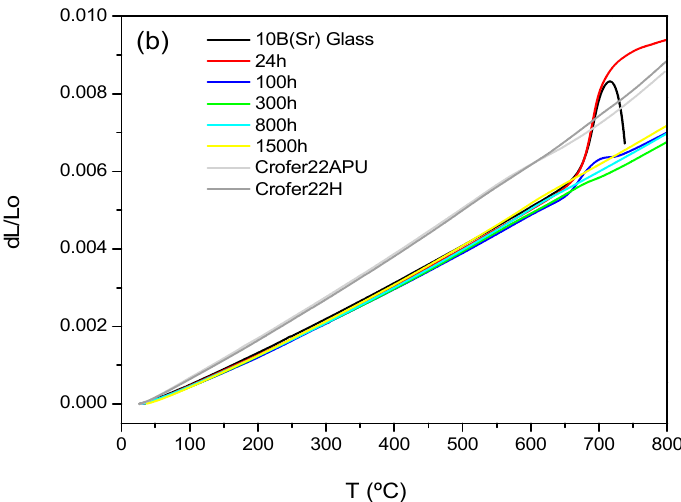
Figure 7. Thermal expansion of the original glasses and glass-ceramics ( a ) 7.5B (Ba) treated at 800 °C and ( b ) 10B (Sr) treated at 750 °C at different times.